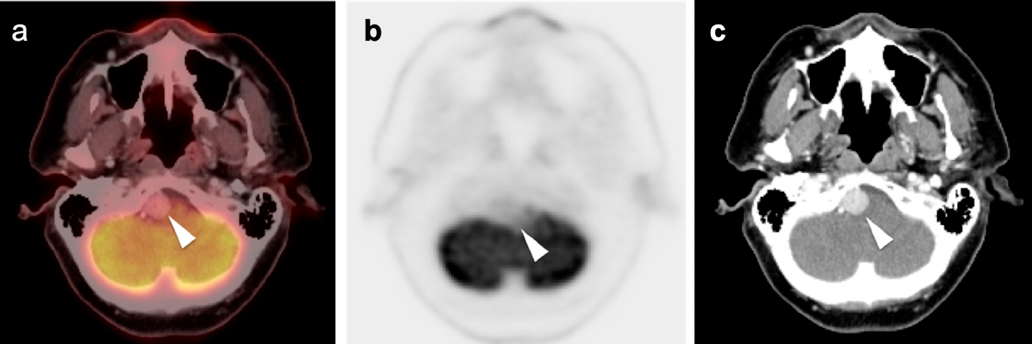
Figure 49. Meningioma. ( a ) Axial fused FDG PET ‐ CT image demonstrates a right posterior fossa hypometabolic enhancing mass with broad ‐ based abutment of the basion (white arrowhead). ( b ) Axial PET only image demonstrates hypometabolism of the mass (white arrowhead), compared to adjacent normal cerebellum, an indicator that this is a lower grade meningioma. ( c ) Axial contrast ‐ enhanced CT confirms the enhancing mass, typical in appearance for a meningioma (white arrowhead).